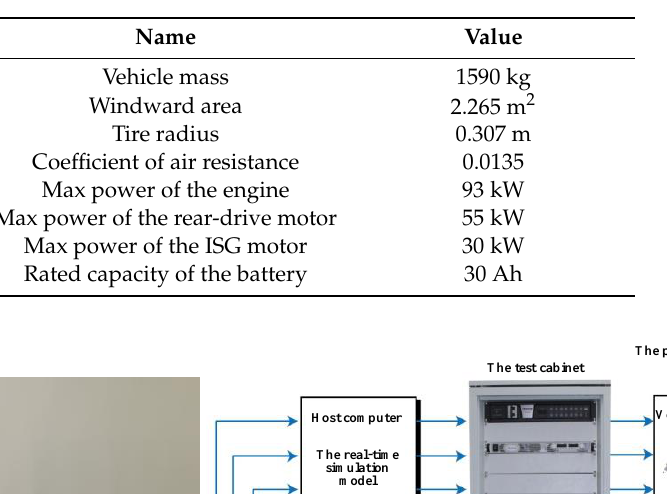
Table 1. Main parameters of the plug-in 4WD hybrid electric vehicle (HEV).